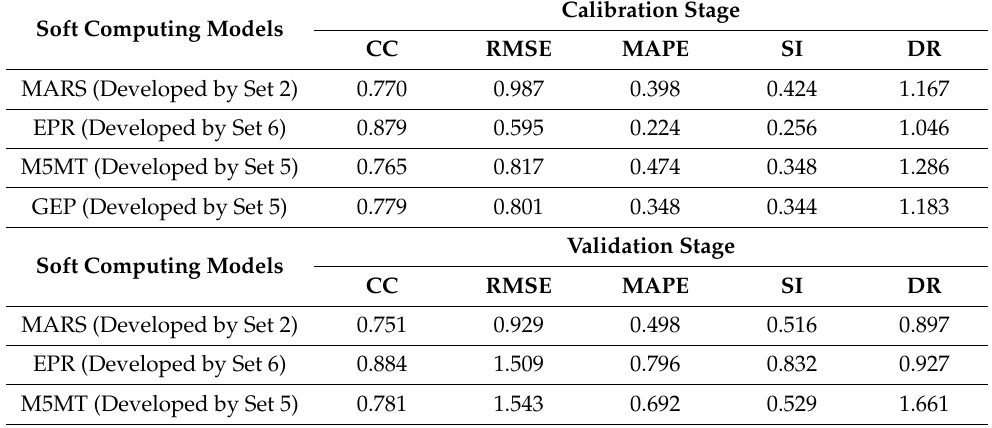
Table 12. The best statistical performances of the soft computing models for prediction of V H *.